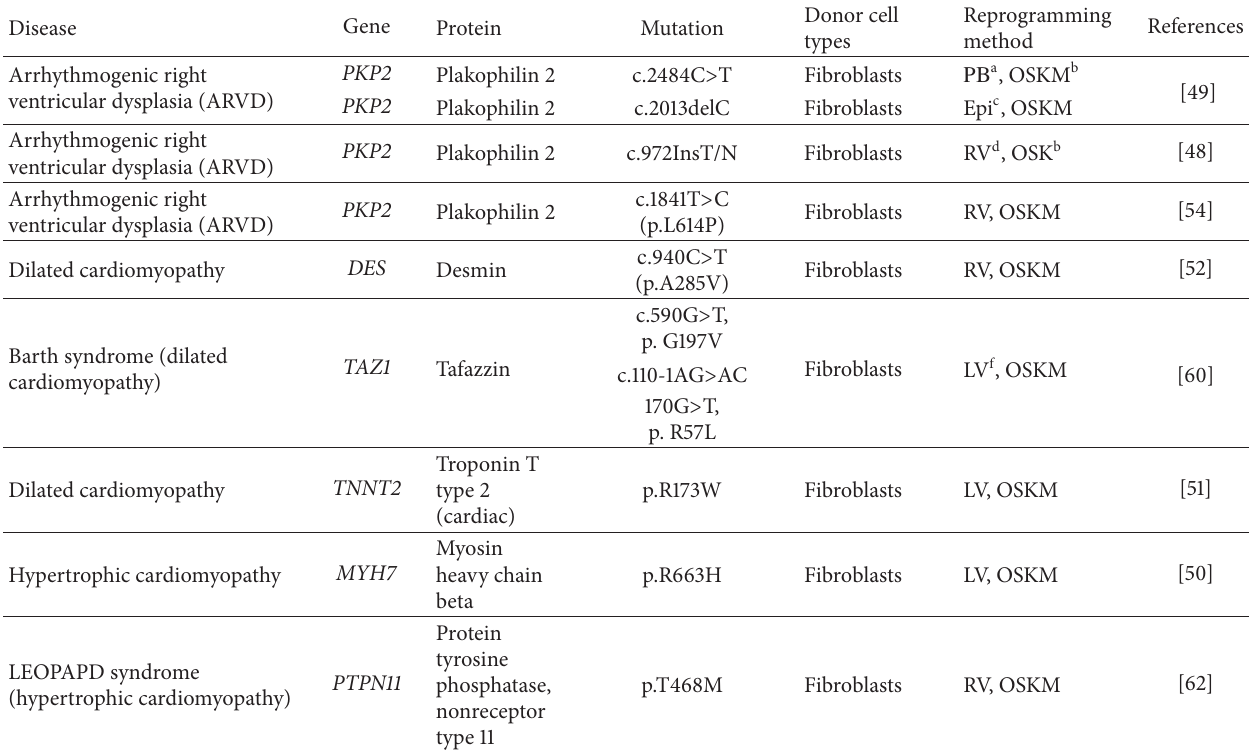
Table 5: Human IPSC-derived patient-specific cardiomyopathy cell models.